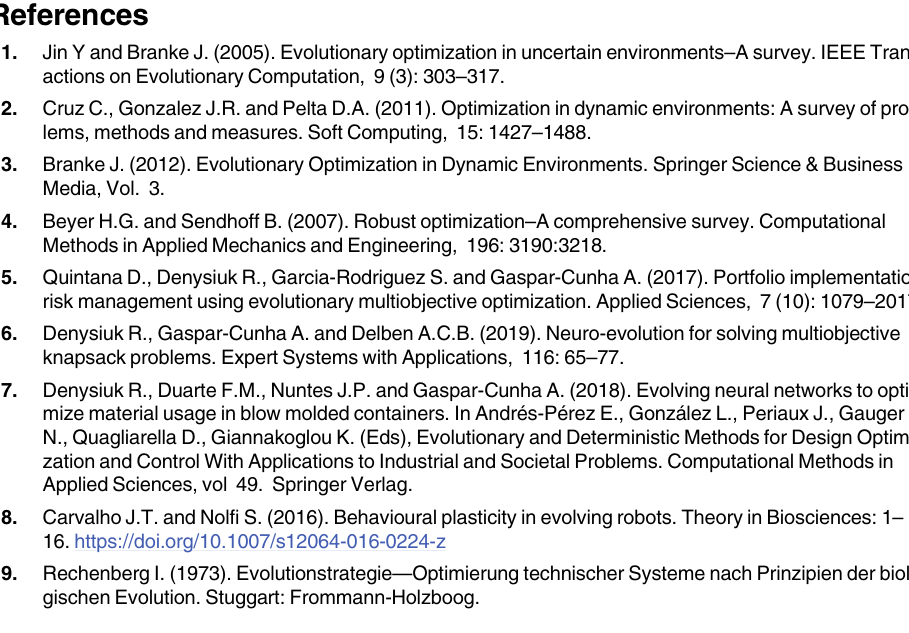
S4 File. An example of evolved swarmbot displaying a dynamical chain strategy. (ZIP) S5 File. A second example of evolved swarmbot displaying a dynamical chain strategy. (ZIP) S6 File. An example of swarmbot that subdivides itself in two subgroups playing the role of nest markers and food